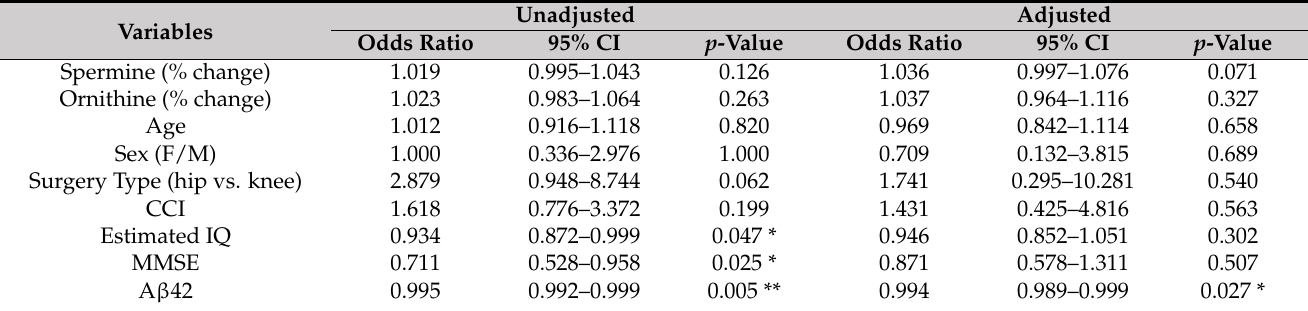
Table 1. Binary logistic regression analysis of predicting variables for delirium. Unadjusted Adjusted Variables Odds Ratio 95% CI p -Value Odds Ratio 95% CI p -Value